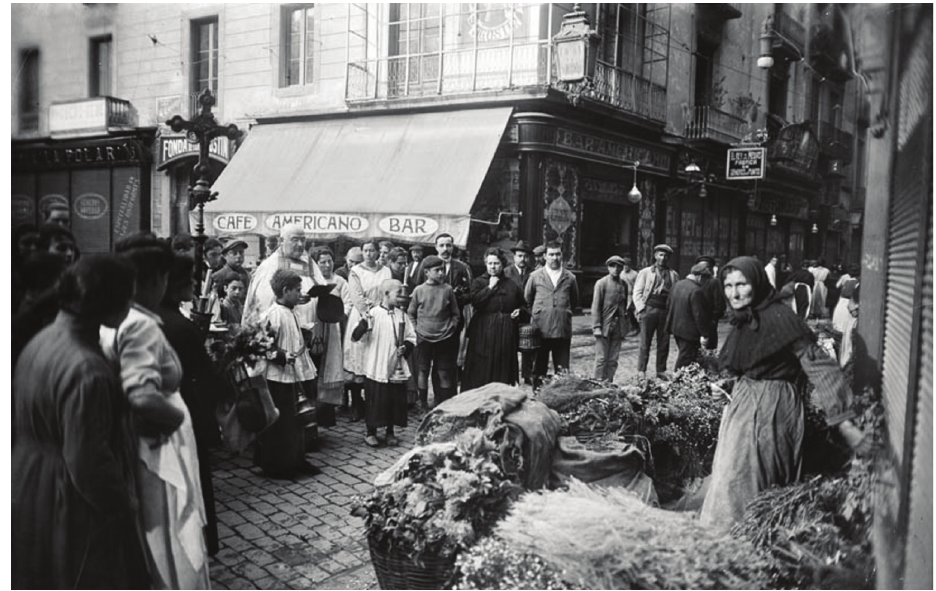
Figure 5: Blessing of the aromatic and medicinal herbs on the occasion of the Fira de Sant Ponç. Hospital Street, Barcelona, ca. 1915, photography © Generalitat de Catalunya. National Archive of